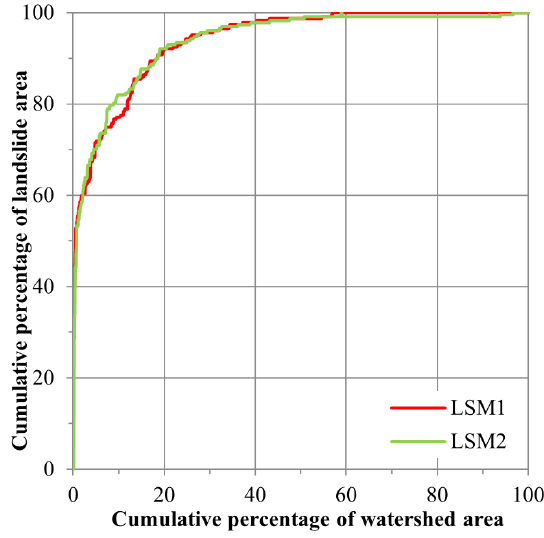
Figure 6. Prediction rate curves (PRCs) of the landslide suscepti- bility (LSM1 – COS and LSM2 –